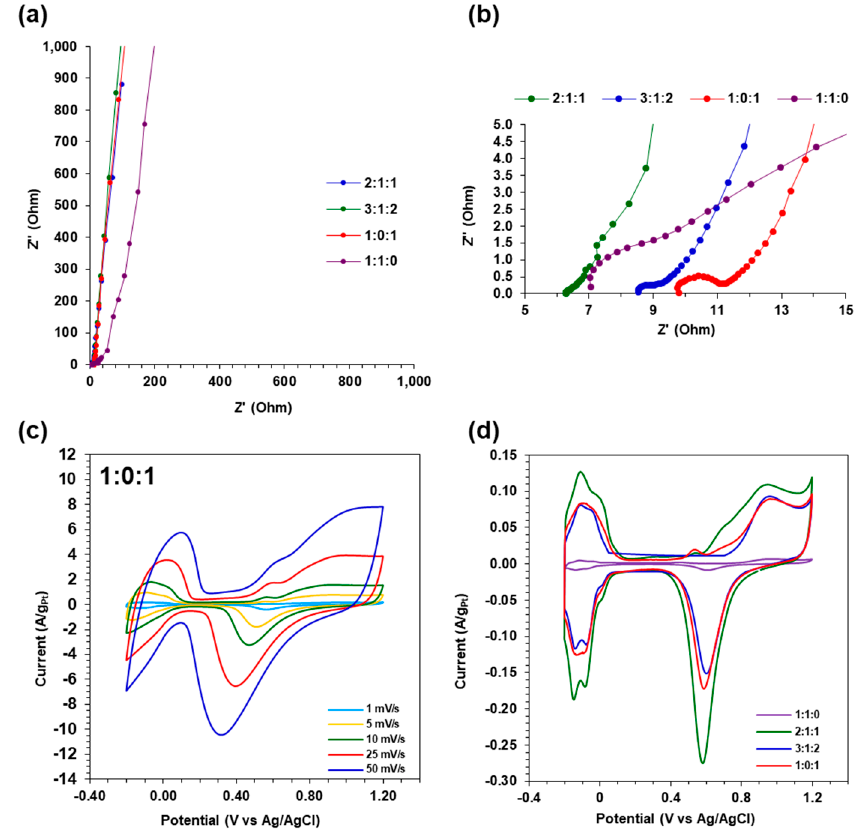
Figure 7. Electrochemical characterization of Pt–Cu macrotubes from Pt 2 − :Pt 2 + :Cu 2 + salts reduced with DMAB. ( a ) Electrochemical impedance spectroscopy (EIS) in 0.5 M H 2 SO 4 at frequency range of 1 MHz to 1 mHz. ( b ) High-frequency EIS from (a); (inset) EIS spectrum for 1:1:0. ( c ) Cyclic voltammetry (CV) in 0.5 M H 2 SO 4 for Pt–Cu macrobeams from a 1:0:1 Pt 2 − :Pt 2 + :Cu 2 + salt ratio, in 0.5 M H 2 SO 4 for scan rates of 1, 5, 10, 25, and 50 mV / s. ( d ) CV in 0.5 M H 2 SO 4 and 0.5 mV / s scan rate for macrotubes with Pt 2 − :Pt 2 + :Cu 2 + salt ratios of 1:1:0, 2:1:1, 3:1:2, and